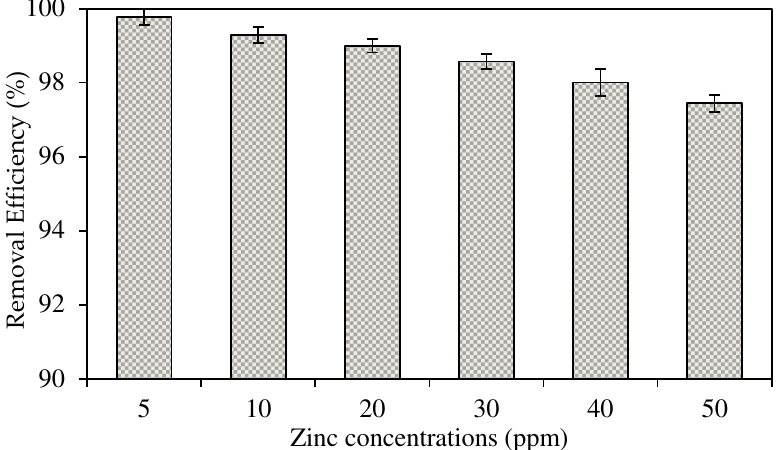
Figure 13. The Zn 2+ removal efficiency percentage of the W3 membrane.